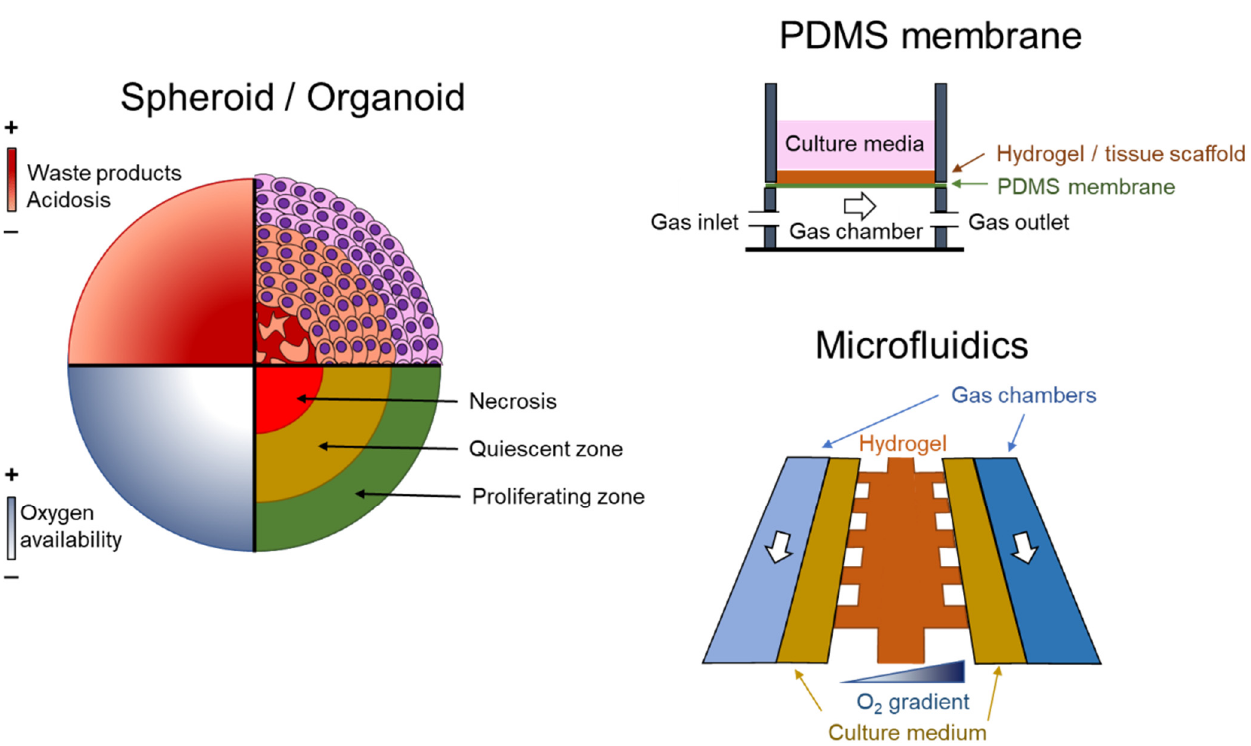
Figure 1. Examples of experimental models. On the left, the absence of vascularization in spheroids and organoids causes a heterogeneous distribution of oxygen, waste products and acidosis. These structures are characterized by a well-irrigated proliferating layer in the periphery, a quiescent layer and a necrotic core. On the right, two methods to create a spatiotemporal O 2 distribution. At the top, a semipermeable polydimethylsiloxane (PDMS) membrane is able to produce fast changes in O 2 in cell culture, and at the bottom, by using microfluidic devices.